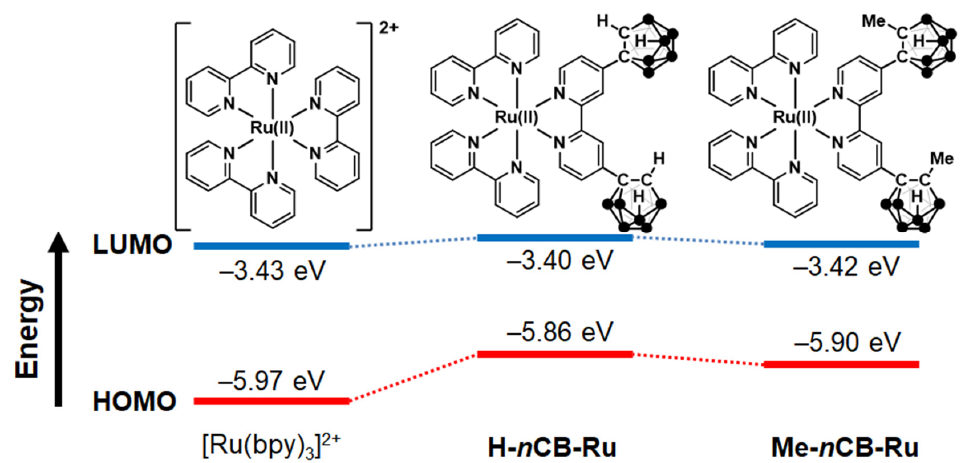
Figure 3. Estimated energy levels of frontier orbitals of the ruthenium complexes from electro- chemical and optical data. and optical